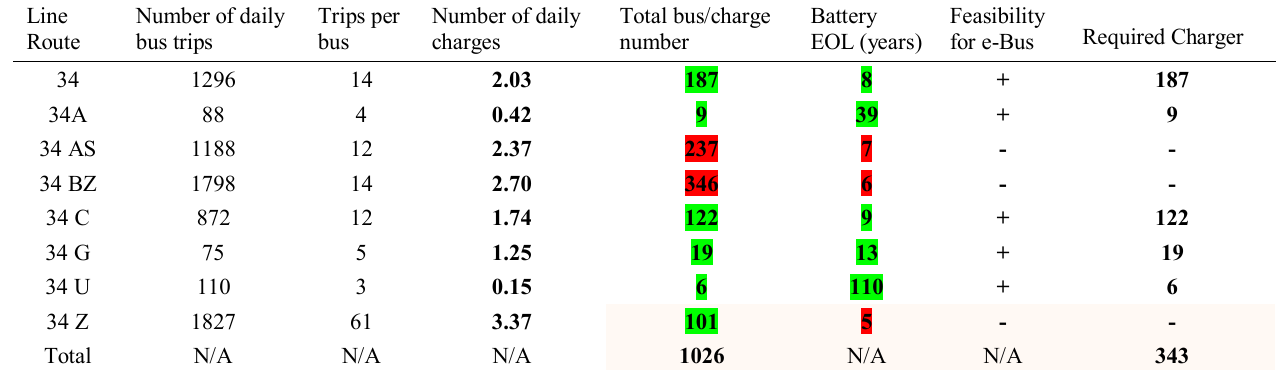
NUMBER OF DAILY CHARGES PER